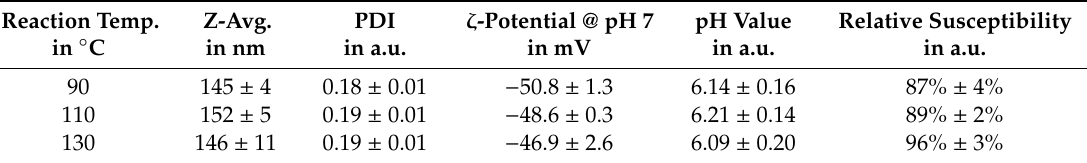
Figure A5. Transmission electron microscopy (TEM) images of ( a ) Cit-SPIONs and ( b ) Cit-Au-SPIONs. Table A1. Comparison of the parameters of Cit-Au-SPIONs with varied reaction temperatures. ζ -Potential @ pH 7 Reaction Temp. Z-Avg. PDI Relative Susceptibility in ◦ C in nm in a.u. in mV in a.u. in a.u.